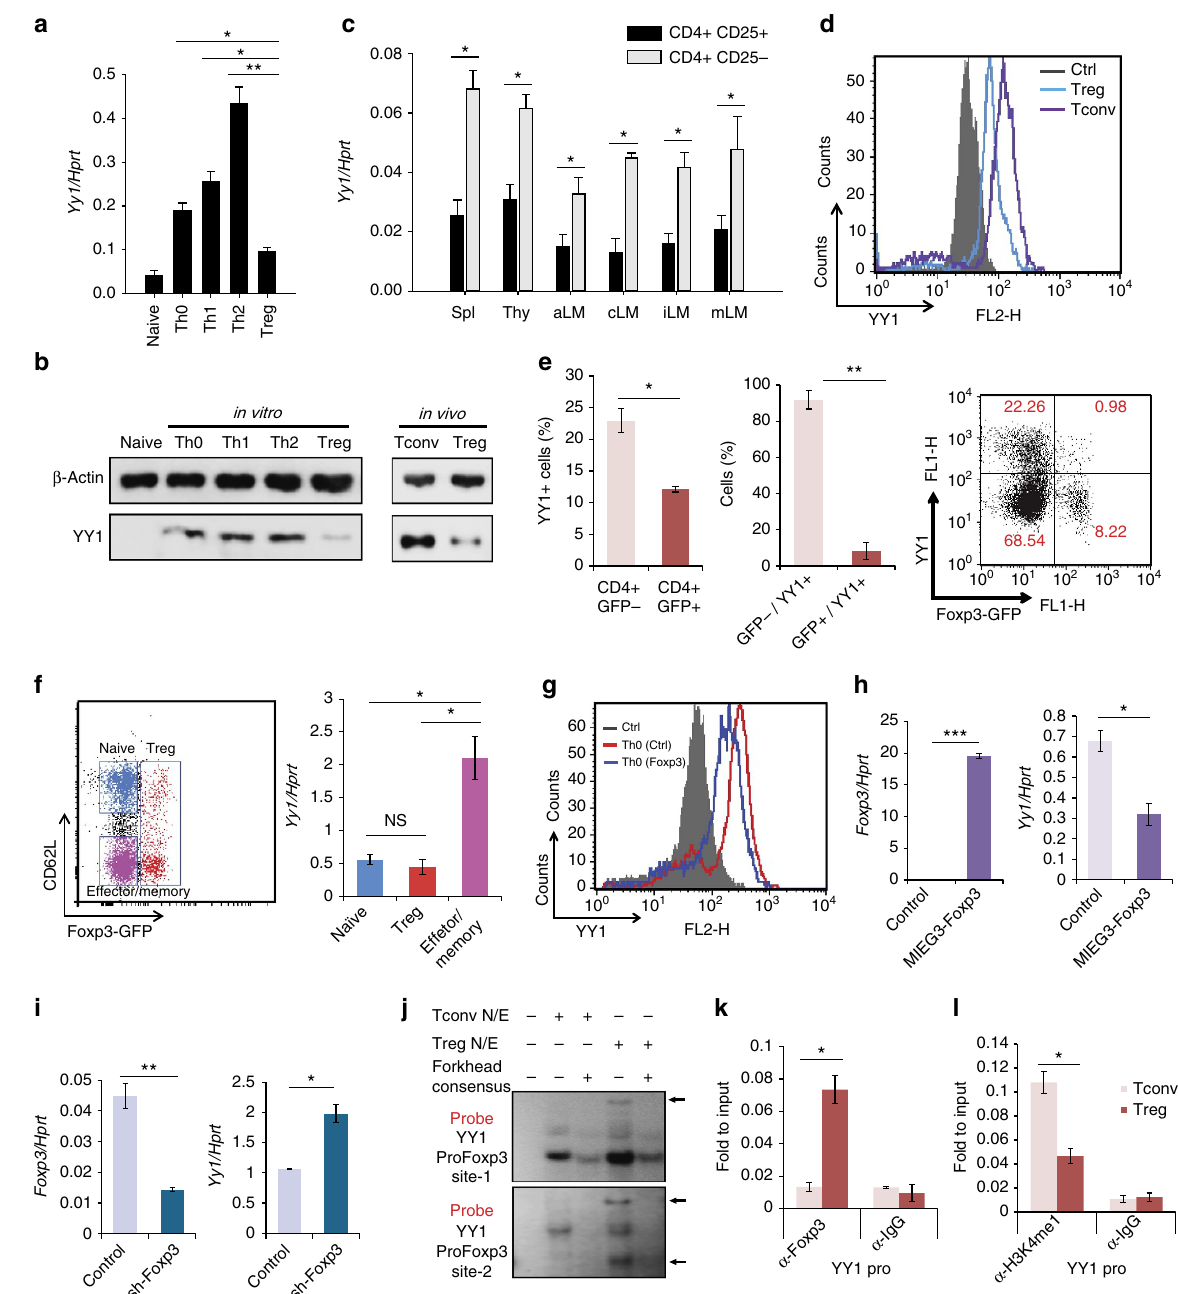
Figure 1 | Expression of YY1 is low in T reg cells. ( a ) Naı¨ve CD4 T cells from WT mice were differentiated into Th0, Th1, Th2 and T reg cells for 5 days. Relative amount of Yy1 transcript was measured by qRT–PCR. ( b ) Relative amounts of YY1 protein in in vitro -differentiated CD4 T cells or splenic T conv (CD4 þ CD25 (cid:2) ) and T reg (CD4 þ CD25 þ ) cells were measured by immunoblot analysis. ( c ) Relative amounts of Yy1 transcript in T conv and T reg cells in axillary (aLN), cervical (cLN), inguinal (iLN) and mesenteric (mLN) lymph nodes and spleen (spl) were detected by qRT–PCR. ( d ) Amounts of YY1 protein in T conv or T reg cells were measured using flow cytometry. IgG: isotype control. ( e ) CD4 cells were enriched from splenocytes of Foxp3-eGFP mice, and then YY1 underwent intracellular staining. The percentage of YY1 þ cells from CD4 þ GFP þ (T reg ) and CD4 þ GFP (cid:2) (non-T reg ) were shown (left), the percentage of T reg (GFP þ ) and non-T reg (GFP (cid:2) ) from YY1 þ cells were shown (centre) and the FACS plot is shown (right). ( f ) CD4 Tcells from Foxp3-eGFP mice were stained with CD62L antibody. Naı¨ve, effector and T reg cells were sorted (left) and relative amounts of Yy1 transcript were measured by qRT–PCR (right). ( g ) Control GFP vector or Foxp3 expression vector was transduced into Th0 cells. After 4 days, YY1 protein was detected by flow cytometry. IgG: isotype control. ( h ) GFP þ cells from g were isolated, and relative amounts of Yy1 and Foxp3 transcripts were measured using qRT–PCR. ( i ) WTnaı¨ve CD4 Tcells were transduced with GFP containing control or sh-Foxp3 vectors and differentiated into T reg cells for 4 days. Relative amounts of Yy1 and Foxp3 transcripts forkhead consensus sequence (x80). Arrows indicate Foxp3-DNA complexes. ( k – l ) Binding of Foxp3 ( k ) and H3K4me1 ( l ) in T reg or T conv cells